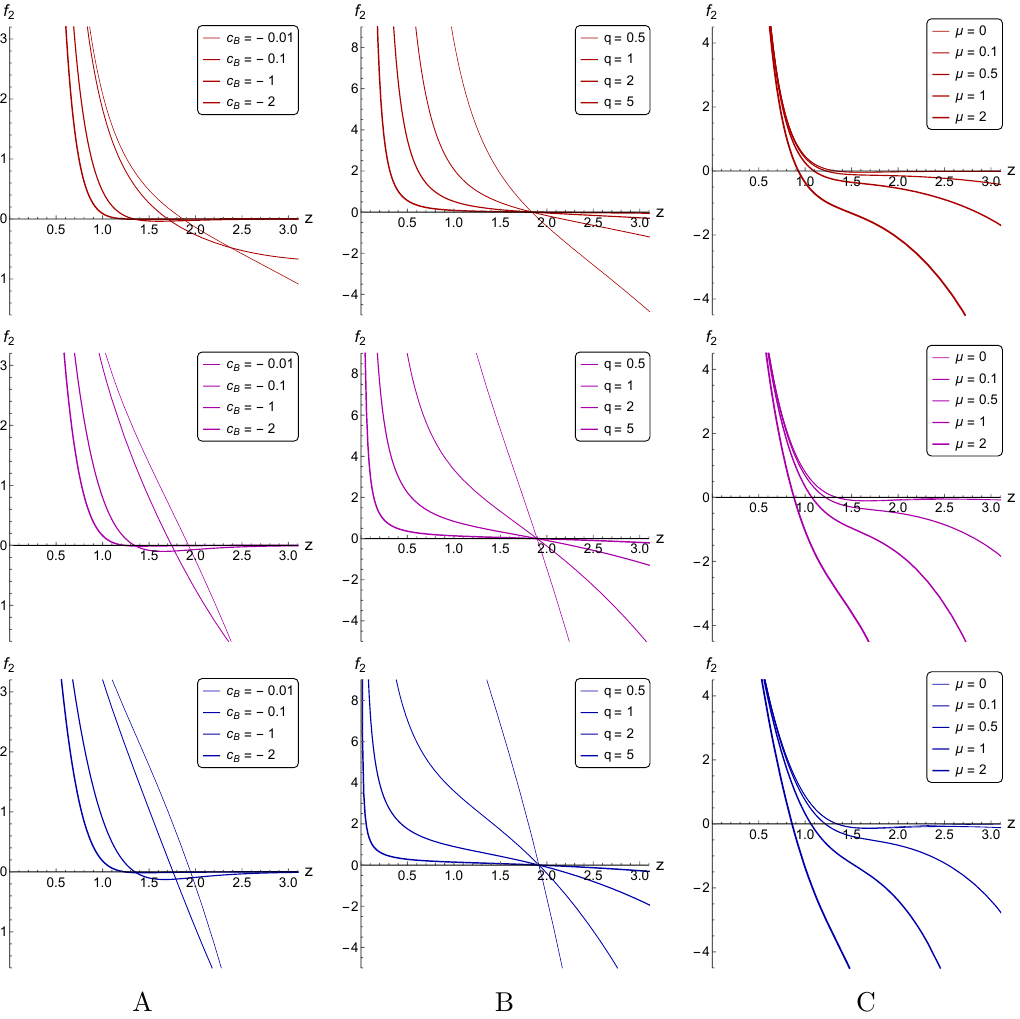
Figure 3 . Coupling function f 2 ( z ) for different c B , µ = 0 , q = 1 (A), for different q µ = 0 , c B = − 1 (B), for different µ , c B = − 1 , q = 1 (C); ν = 1 . 5 (1-st line), ν = 3 (2-nd line) and ν = 4 . 5 (3-rd line), c = 0 . 227 , z h = 1